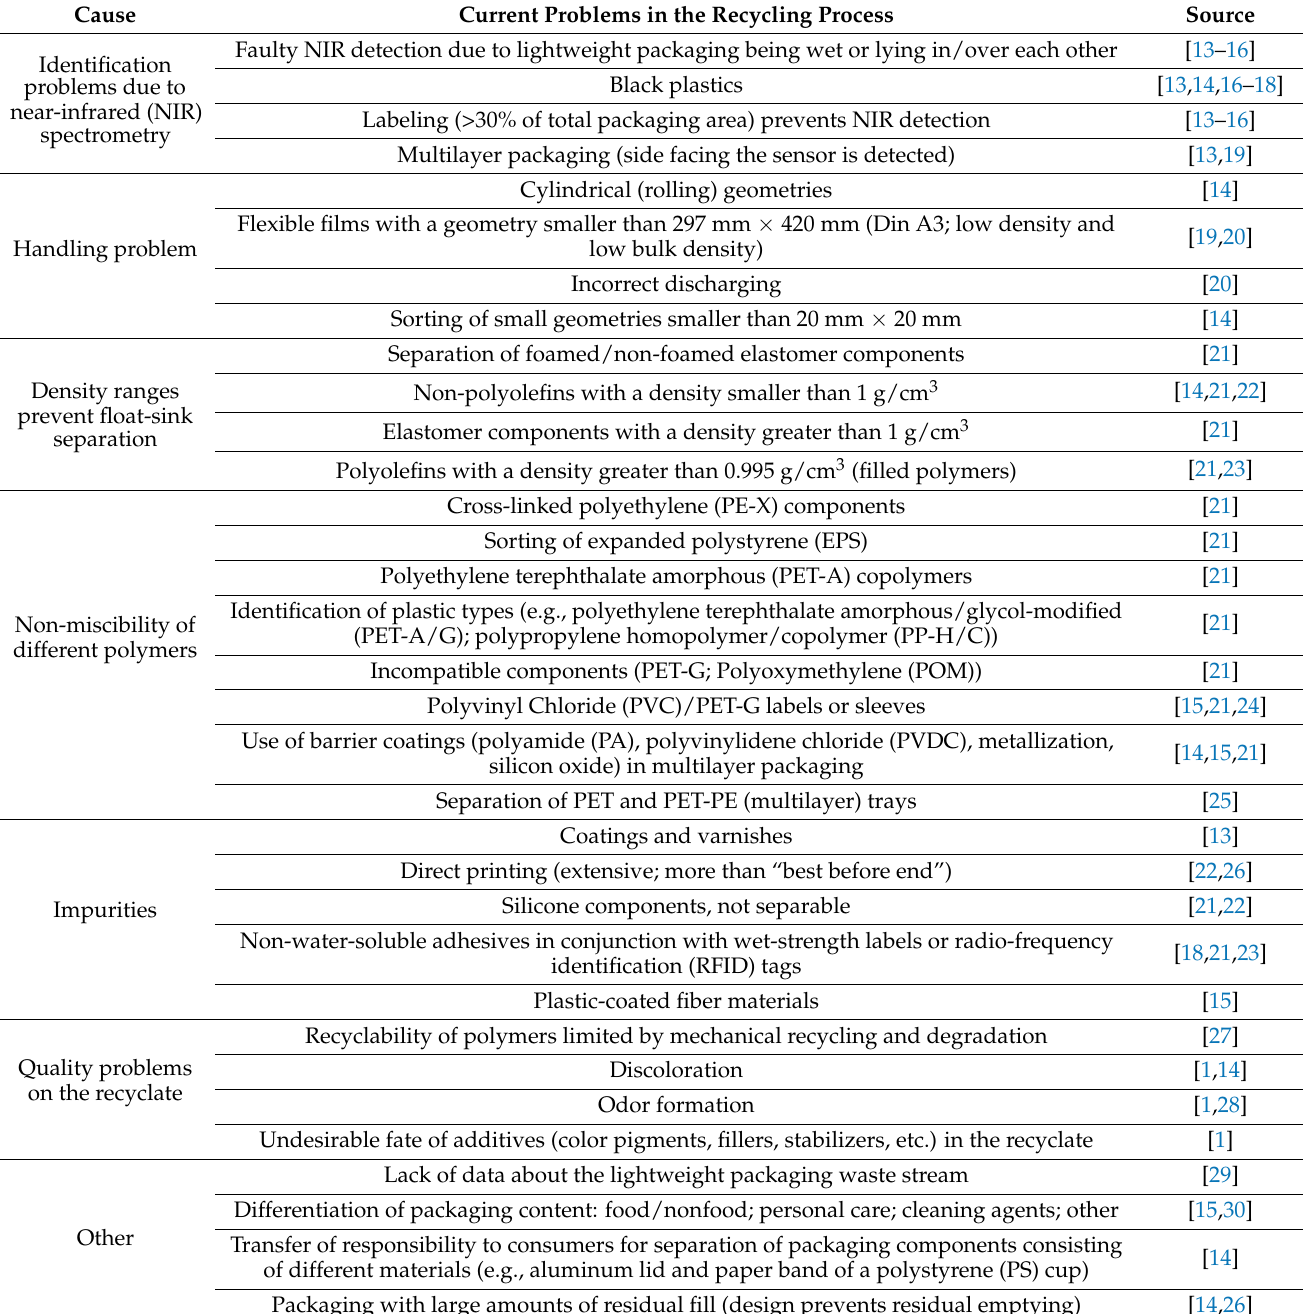
Table 1. Current challenges in the plastics recycling process and their